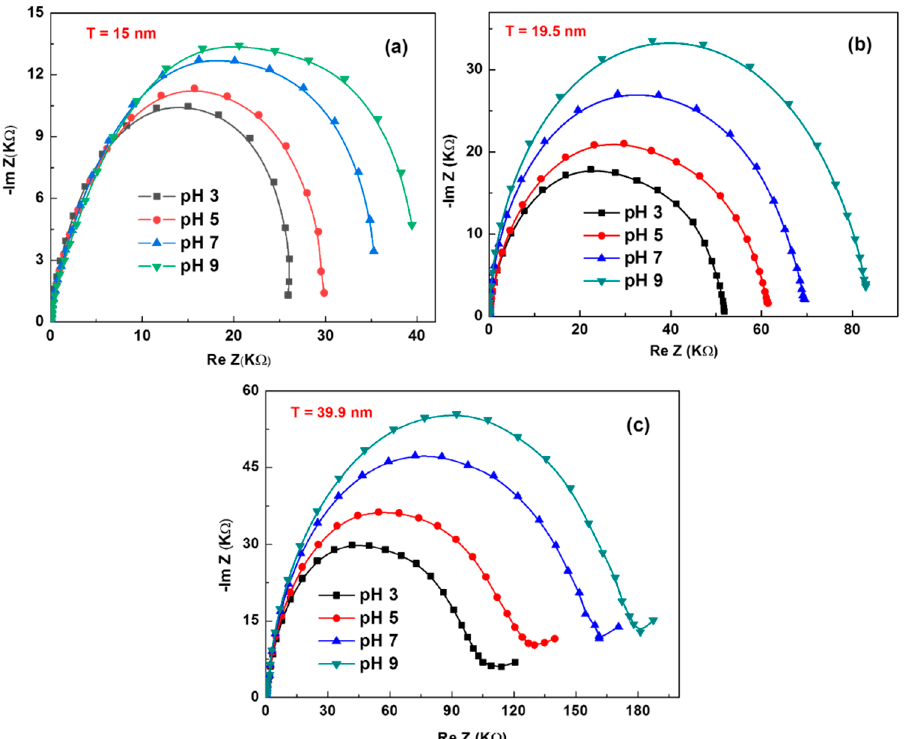
Figure 8. Nyquist plots at different pH for different hafnium thicknesses ( a ) 15.0 nm, ( b ) 19.5 nm and ( c ) 39.9 nm.